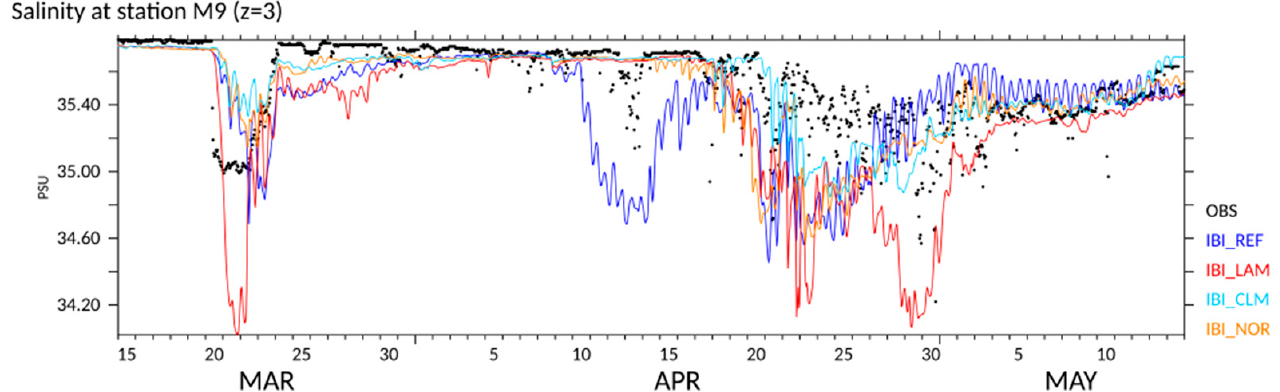
Figure 9. Timeseries of salinity at mooring station M9, at the shelf-break of Northwestern Iberia, from 15 March to 15 May 2018. Observed salinity represented by black dots and the different IBI model scenarios by solid lines (IBI_REF in blue, IBI_CLM in light blue, IBI_LAM in red and IBI_NOR in orange color).